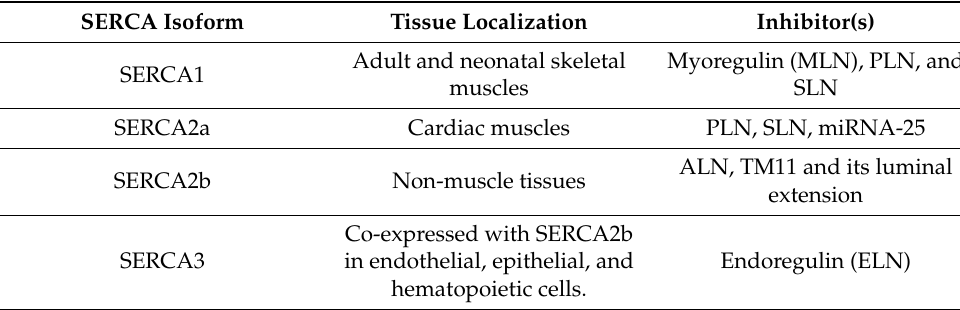
Table 1. Sarcoplasmic or endoplasmic Ca 2+ -ATPase isoforms. SERCA Isoform Tissue Localization